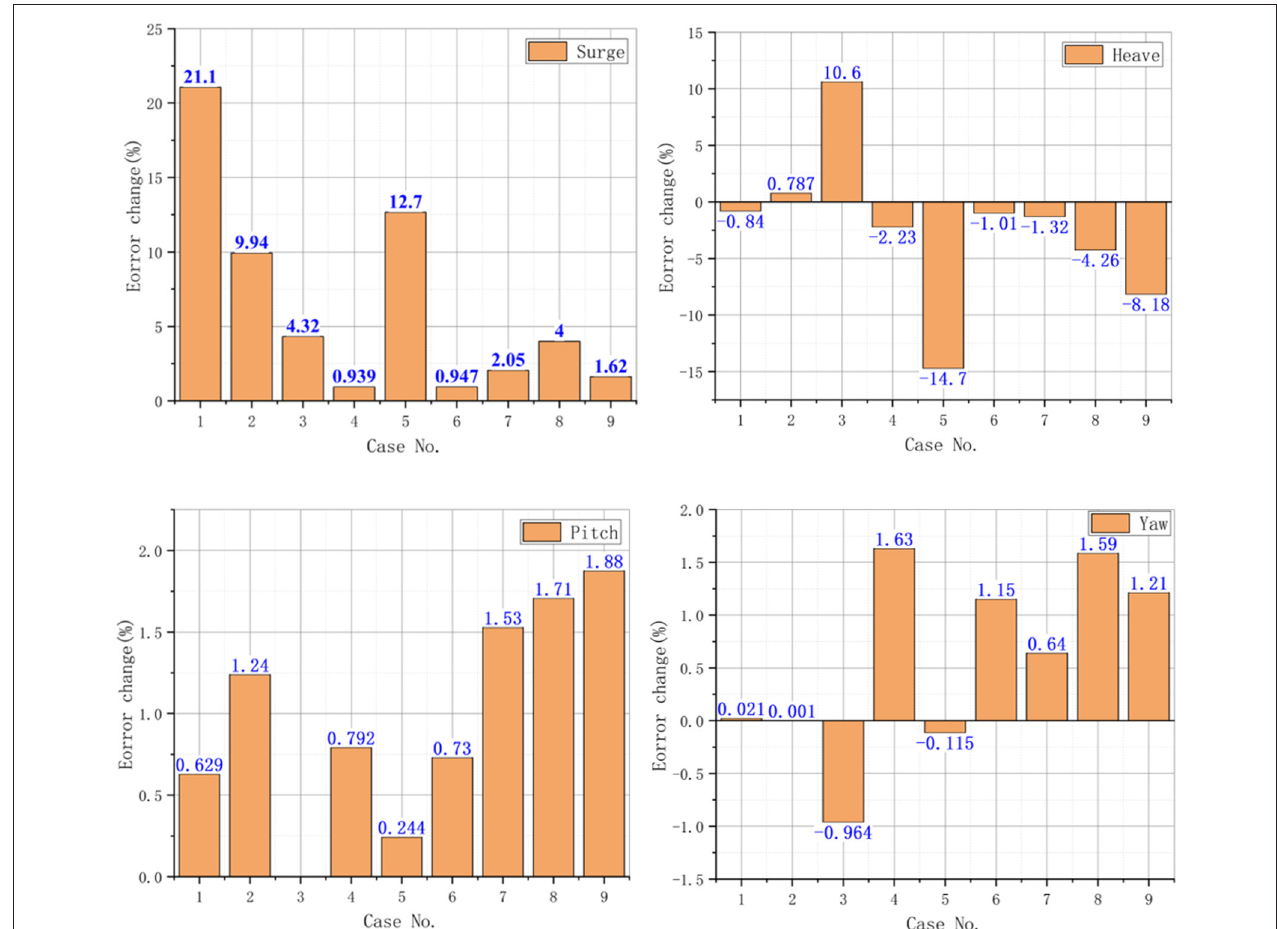
FIGURE 6 | Variation of error of platform motions in 9 cases.